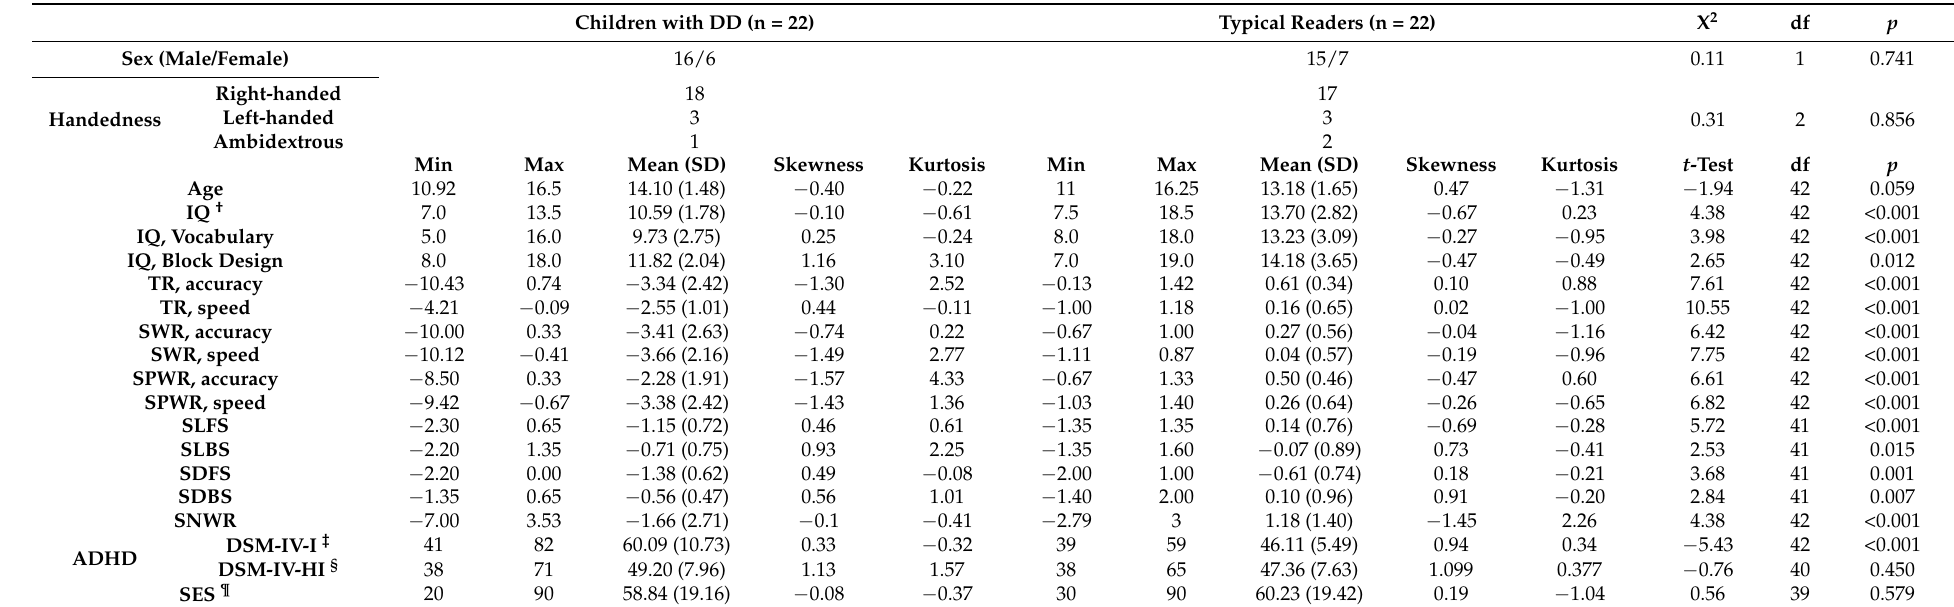
Table 1. Descriptive statistics of demographic and neuropsychological